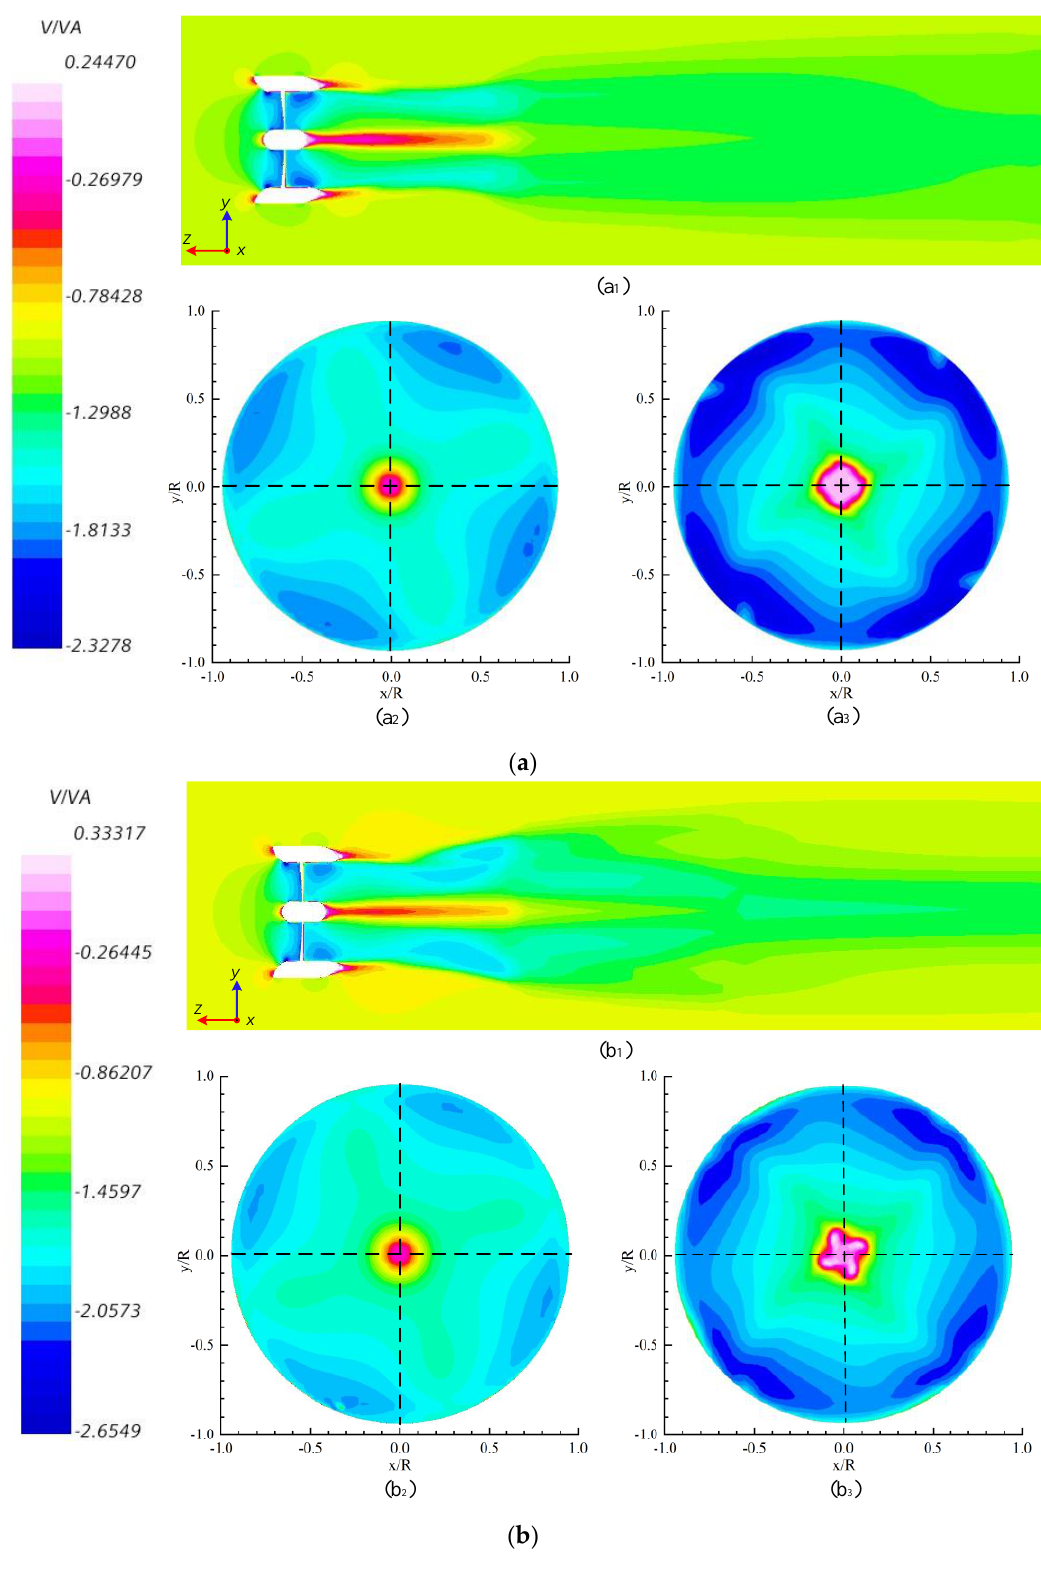
Figure 12. Nondimensional axial velocity distribution of the RDT flow field. ( a ) Prototype RDT. ( b ) Optimized RDT.